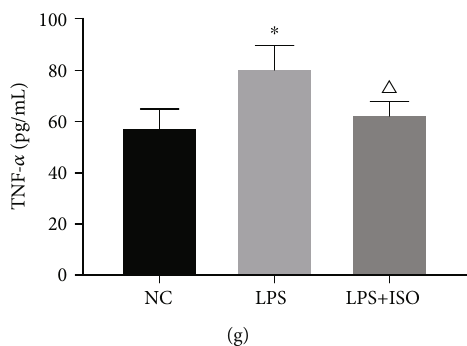
Figure 1: E ff ects of ISO on LPS-induced NHAs proliferation, apoptosis, and in fl ammatory response. ∗ p < 0 : 05 vs. the NC group; Δ p < 0 : 05 vs. the LPS group. (a – c) The proliferation of NHAs measured by MTT. (d) NHA apoptosis measured by Annexin V-FITC/PI. (e – g) Expression of IL-6, IL-1 β , and TNF- α in NHAs determined by ELISA.